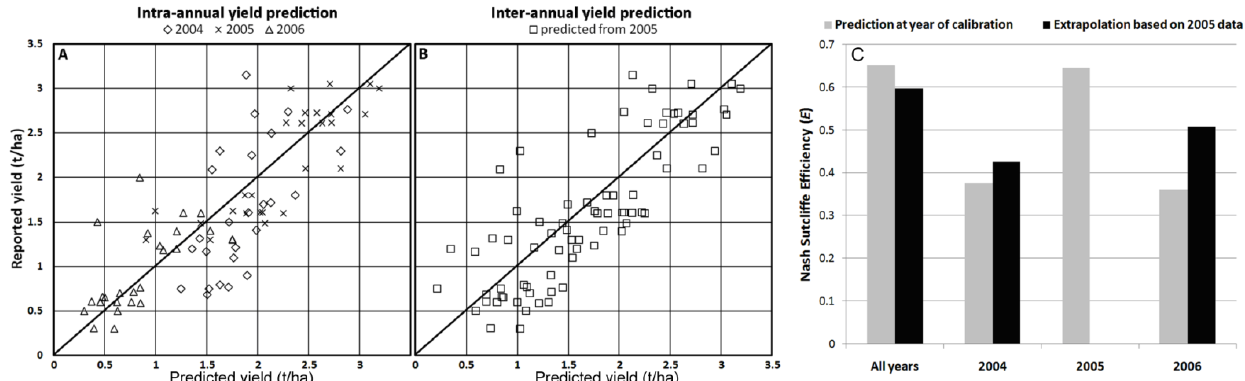
Figure 5. ( A ) Scatter plot of regional yields predicted from yield–NDVI models versus yields reported at the administrative region level for 2004, 2005 and 2006. ( B ) Scatter plot of yields predicted from Landsat NDVI images from 2004, 2005 and 2006 from the yield–NDVI relationship developed in 2005 versus reported yields at the administrative region level. Each data point represents predicted versus reported yield for one administrative region. ( C ) Nash – Sutcliffe efficiency criterion ( E ) for annual, interannual and all-years yield prediction models.